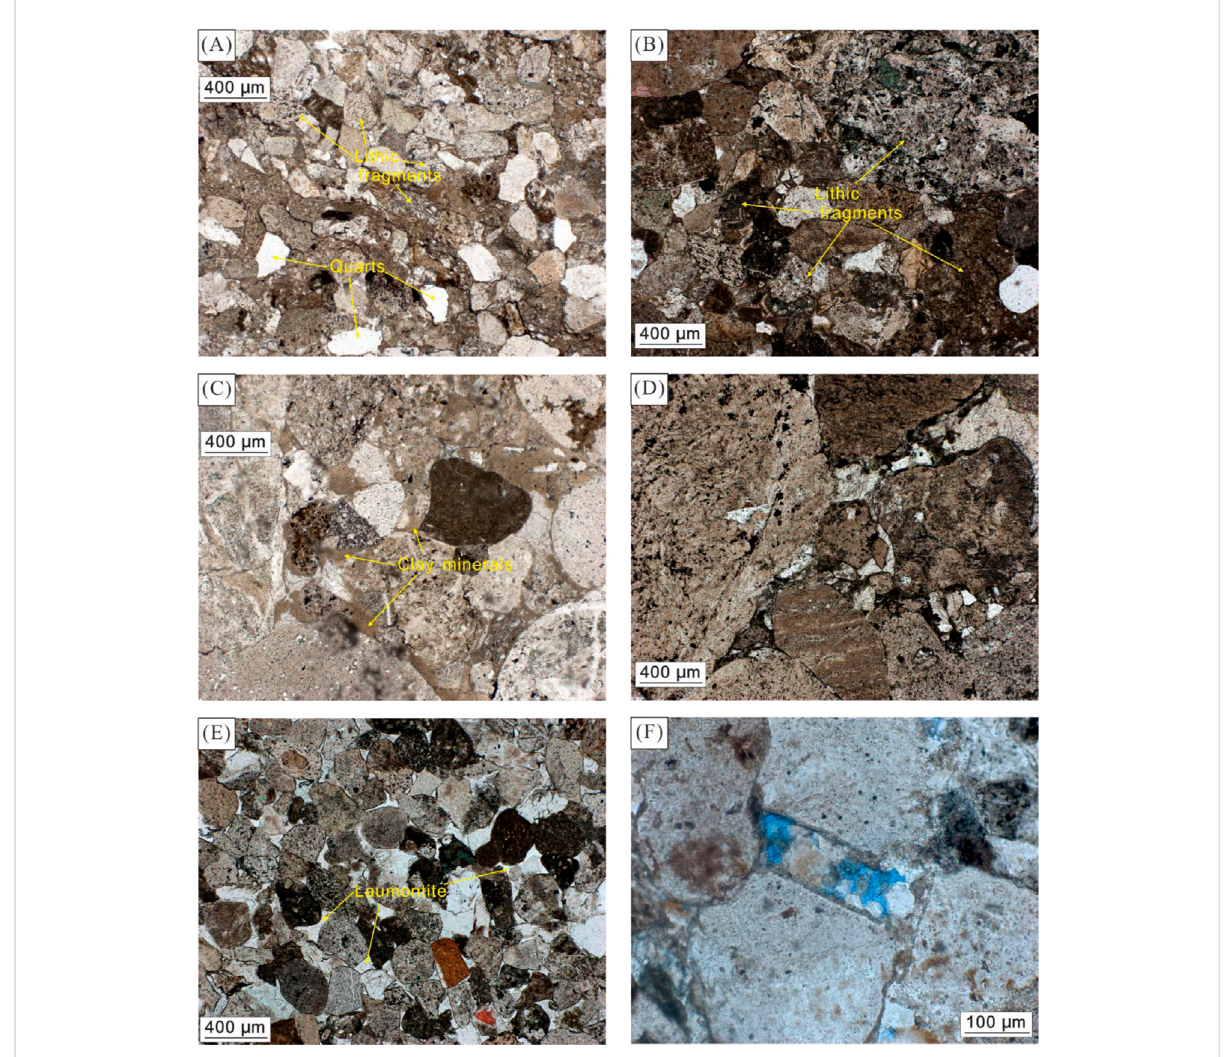
FIGURE 5 Petrological and mineral characteristics of the P 3 w reservoirs in Fukang Sag (A) Well Fu48, 4596.1 m, P 3 w, fi ne and medium-grained clastic sandstone, siliceous 3%, and illite-montmorillonite mixed layer 1%; (B) Well Fu47, 5111.3 m, P 3 w, gravelly medium-grained clastic sandstone, illite- montmorillonite mixed layer 6%; the reservoir istight, and theporesare invisible; (C) Well Fu49, 5402.98 m, P 3 w,unequal grained sandstone, calcite 2%,andillite-montmorillonitemixedlayer6%; (D) WellKT1,5161.0 m,P 3 w,sandyconglomerate; (E) WellFu48,4511.0 m,P 3 w, fi ne-tomedium- grainedclasticsandstone,laumontite6%,andafewmuddyshrinkageporeswereobserved;and (F) WellFu50,4291.46 m,P 3 w,andgravellymedium to coarse-grained clastic sandstone with the intergrain fi lling of laumontite